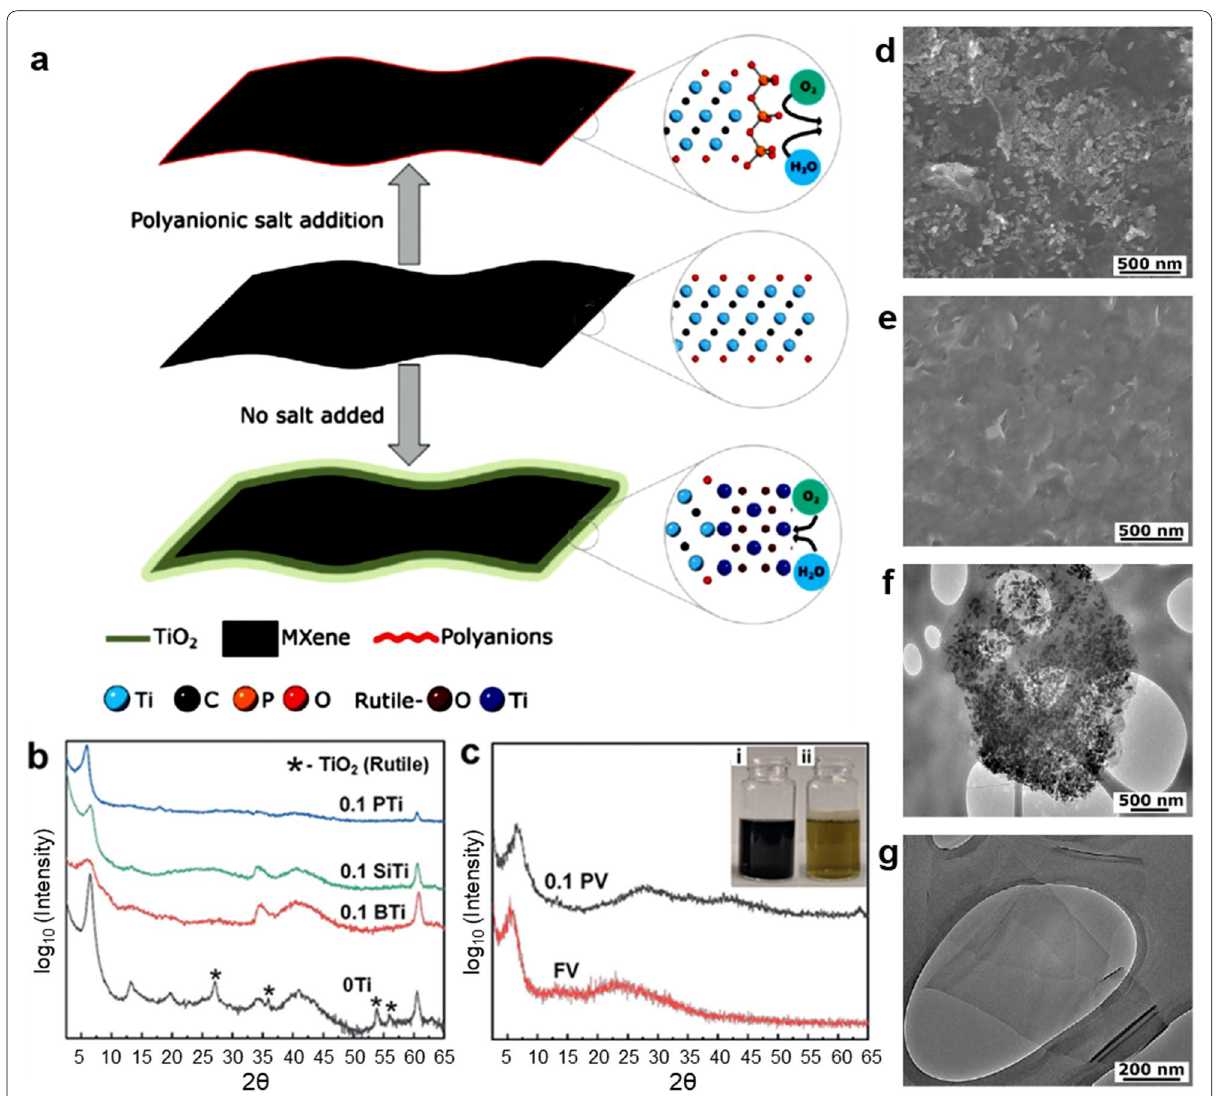
Fig. 7 a Illustration for the edge capping of MXene sheets with polyanions. The middle flake represents a typical as-synthesized fresh MXene flake. The top flake shows that the edge-capping of MXene with polyanions protect it from oxidation, while the bottom bare flake undergoes oxidation over prolonged exposure to water and air. b XRD patterns of 0.1 M polyphosphate-Ti 3 C 2 T x (blue), 0.1 M polysilicate-Ti 3 C 2 T x (green), 0.1 M polyborate-Ti 3 C 2 T x (red), and untreated Ti 3 C 2 T x (black), c XRD patterns of 0.1 M polyphosphate-V 2 CT x (black), and untreated-V 2 CT x (red) samples. Patterns are shifted vertically for clarity. Inset shows digital photographs of (i) 0.1 M polyphosphate-V 2 CT x (left) sample and (ii) untreated V 2 CT x sample (right) after three weeks of exposure to ambient air. Peaks of rutile are marked by asterisks. Typical SEM images of d untreated Ti 3 C 2 T x and e 0.1 M polyphosphate-Ti 3 C 2 T x samples. Typical TEM images of f untreated Ti 3 C 2 T x and g 0.1 M polyphosphate-Ti 3 C 2 T x samples. a - g Reproduced with permissions from ref. [59]. Copyright (2019),